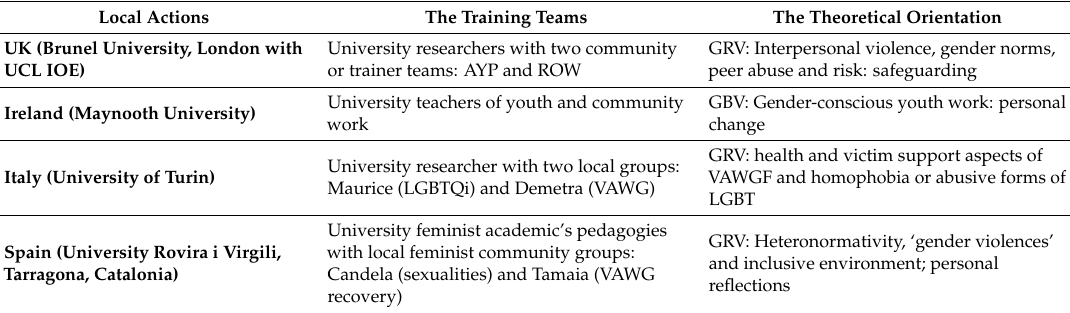
Table 1. The four local actions in the UK, Ireland, Italy and Spain